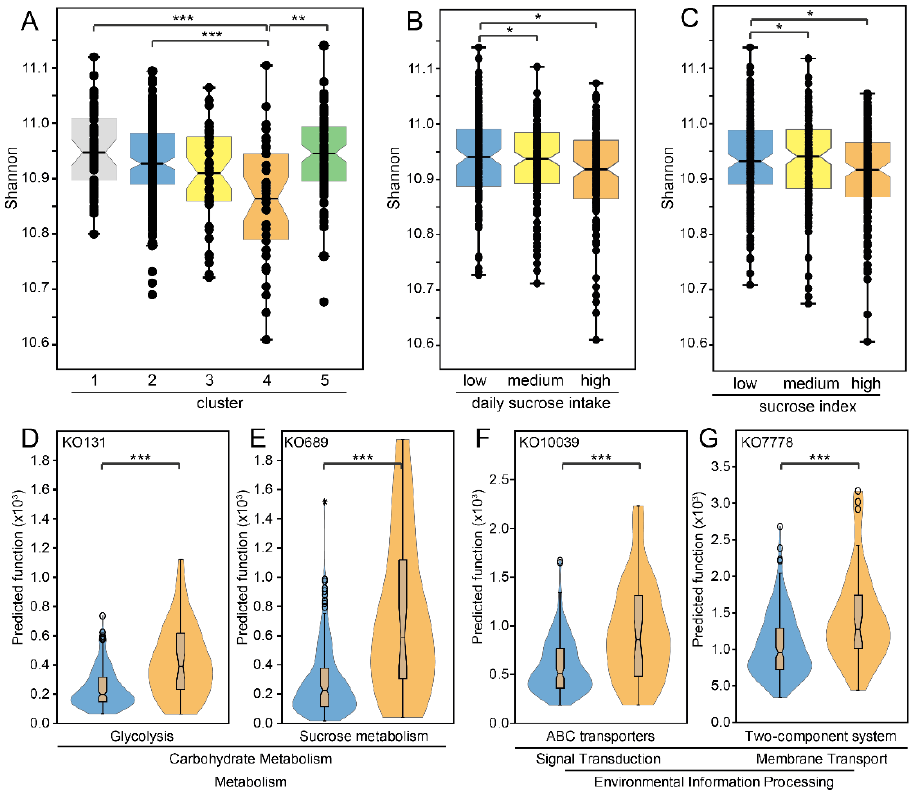
Figure 2. Comparisons of predicted microbiota function (KEGG orthologues, KO) based on 16S rRNA gene sequence information in PICRUSt2. BOX-jitter plots based on Shannon diversity of the predicted functions in ( A ) the 5 clusters, and tertile groups of ( B ) estimated daily sucrose intake and ( C ) a created sucrose index. ( D – G ) Violin plots illustrating two functions linked to carbohydrate metabolism [( D ) glycolysis and ( E ) sucrose metabolism], and two functions linked to environmental information processing [( F ) ABC-transporter and ( G ) two-component system]. Group differences were evaluated by PERMANOVA, * for p < 0.05, ** p < 0.01, and *** p < 0.001 (FDR ad- justed).